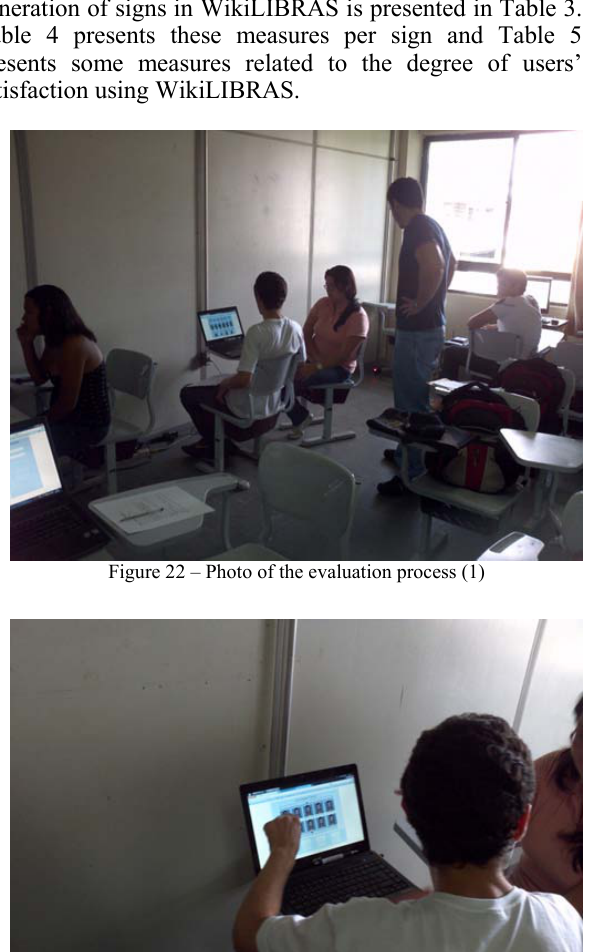
Table 5 - Average scores for the questions about users’